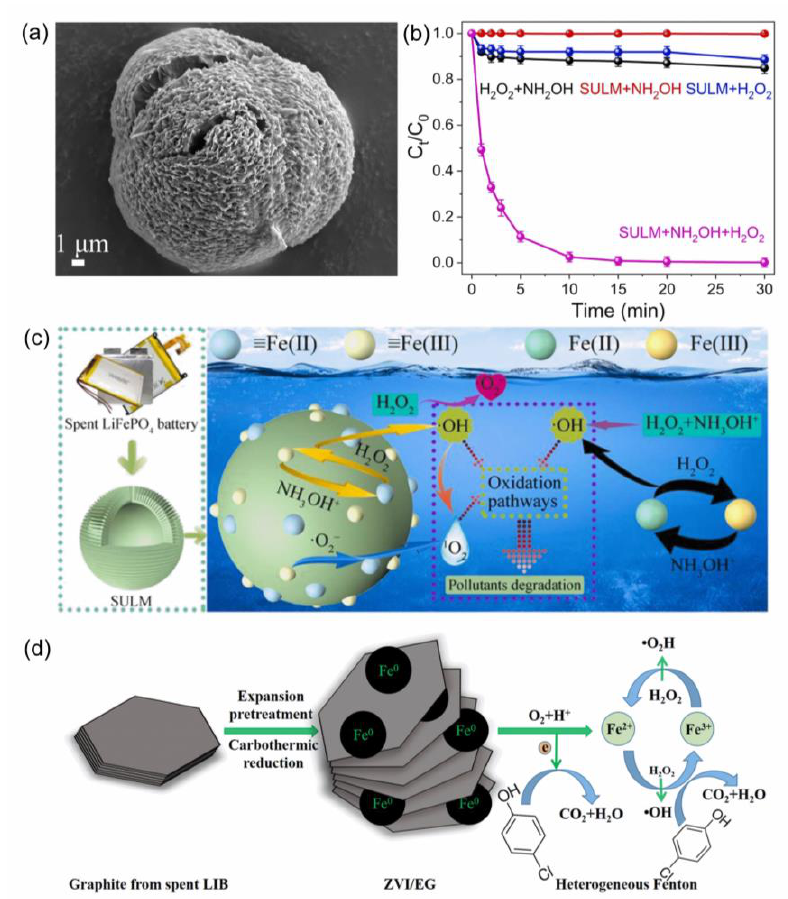
Figure 6. ( a ) The SEM image of SULM, ( b ) degradation efficiency of RhB in SULM + NH 2 OH + H 2 O 2 system, ( c ) schematic illustration of the production process and oxidation pathways of ROS, and ( d ) possible reaction mechanism of ZVI/EG system. Reprinted with permission from Refs. [91,97].